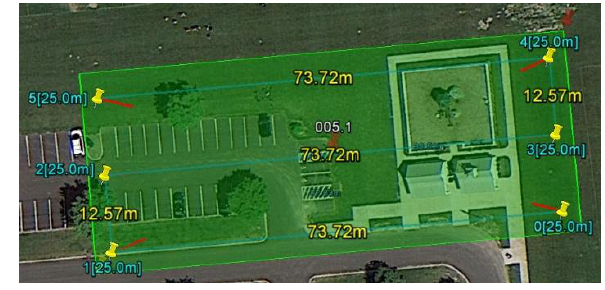
Figure 2. Test flights plan